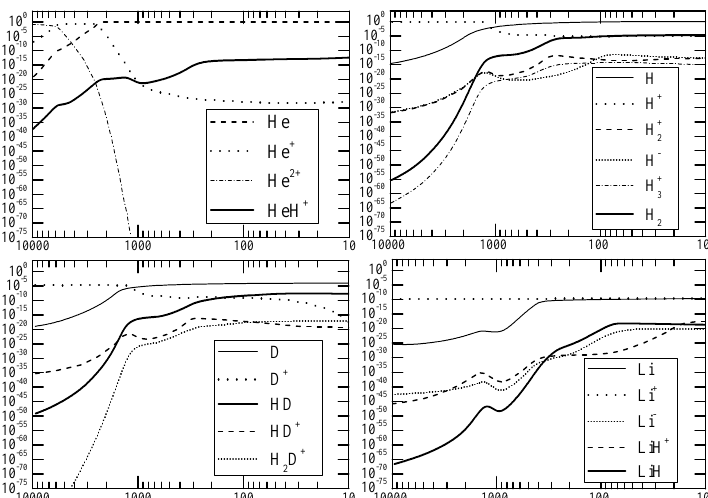
Figure 1. Evaluation of chemical abundances in the standard Big Bang (BB) model. Vertical axes are the relative abundances and the horizontal axes are relative to the redshift (taken from